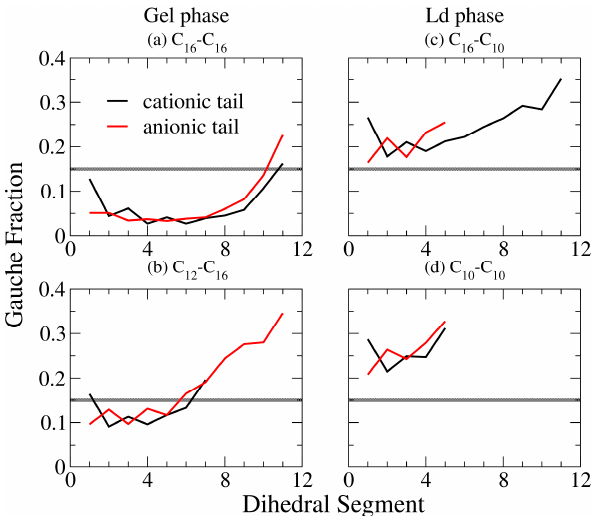
Figure 8. Representative gauche fraction profiles for the cationic (black line) and the anionic (red line) components of the IPA systems ( a ) C 16 TMA + -C 16 S − and ( b ) C 12 TMA + -C 16 S − in gel (S) phase, and ( c ) C 16 TMA + -C 10 S − and ( d ) C 10 TMA + -C 10 S − systems in liquid-disordered (Ld) phase. The gray lines represent the threshold gauche fraction value of 0.15 to distinguish the Ld and S phases.